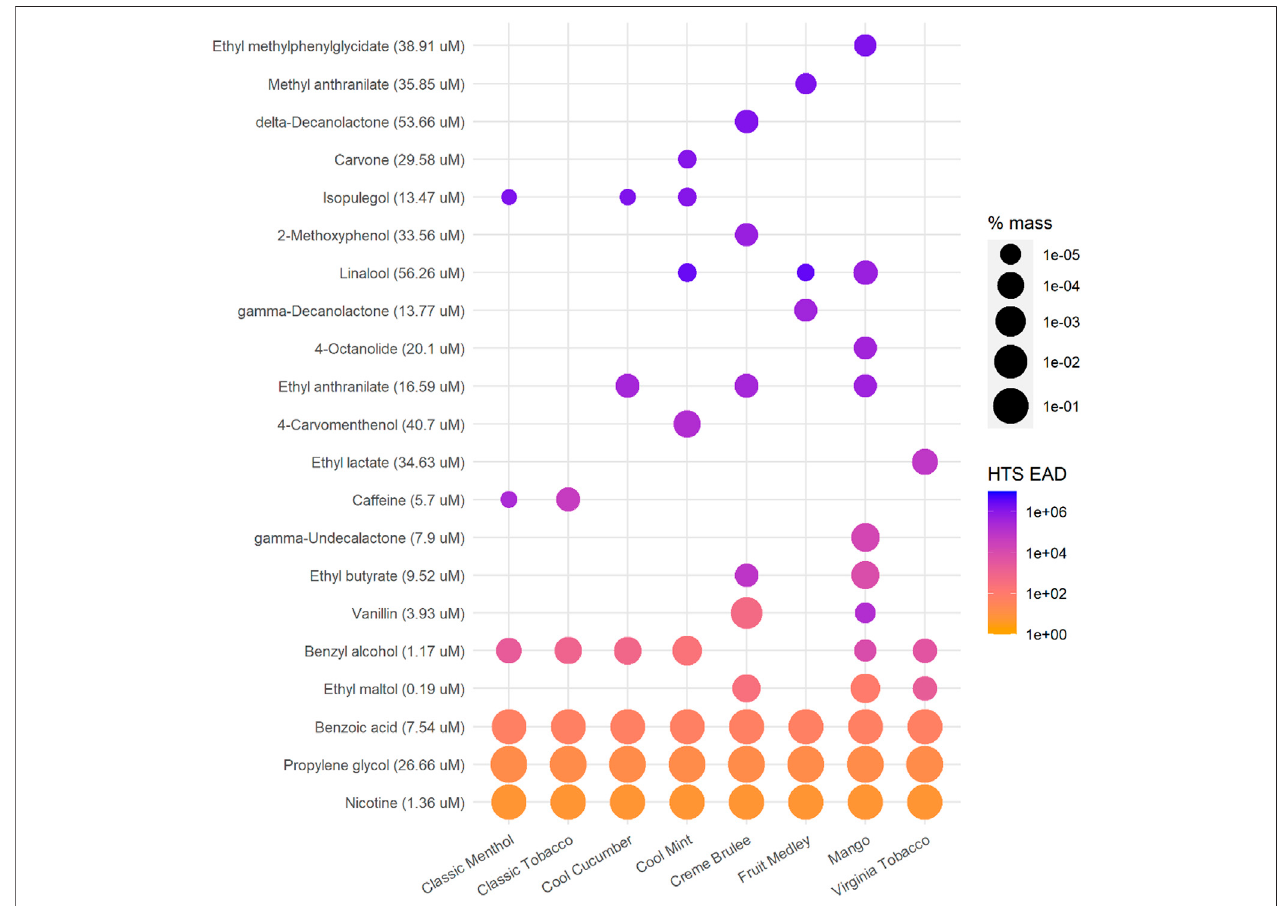
FIGURE3| EADpredictions forindividual ingredients using thesingle actorapproach andthe lowestAC50 values reportedin theHTS datasets.Dataareordered based on the minimum EAD for each ingredient across all mixtures. Orange colors indicate lower EAD estimations (more toxic), while blue colors show higher EAD estimations. The size of dots indicates the mass percentage of the e-liquid mixture for each ingredient (log scale). Note that nicotine and BA represent ∼ 5% mass while PG represents ∼ 30% mass ( Supplementary Table S1 ). The AC50 for each ingredient used in calculating is shown in parentheses next to the ingredient name.